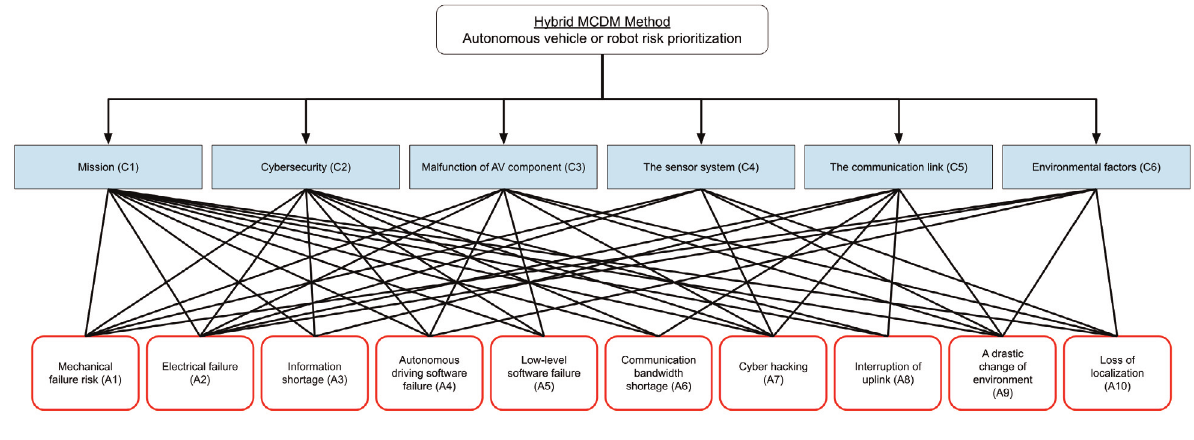
Fig. 4. Decision hierarchy of the risk evaluation problem for mobile robot